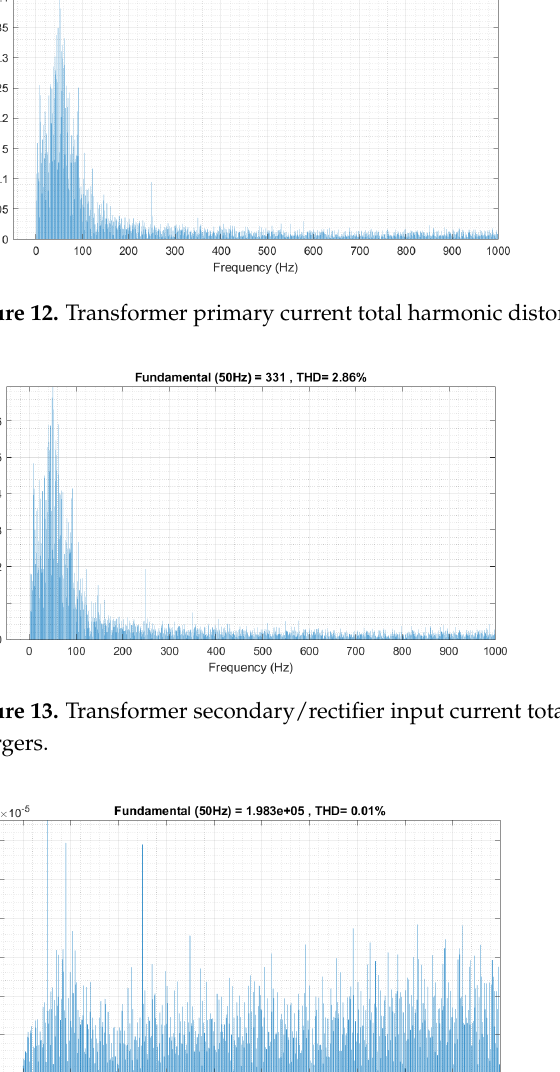
Figure 14. Transformer primary voltage total harmonic distortion for three EV fast chargers .